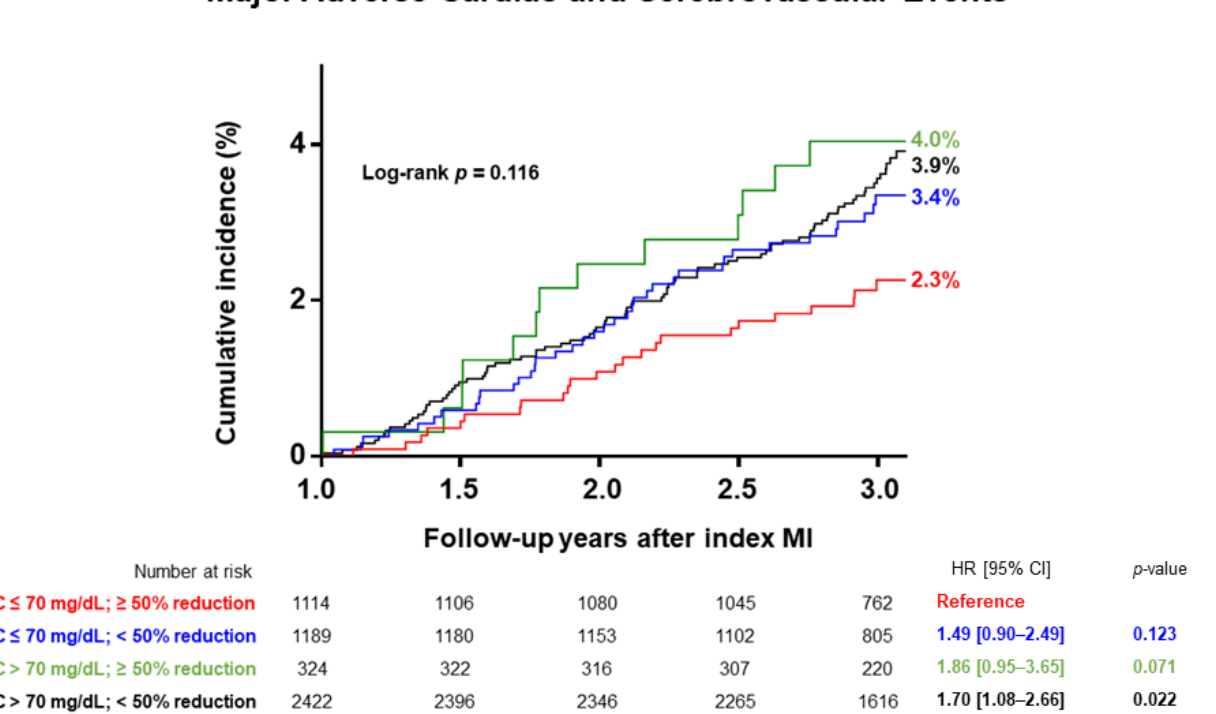
Figure 3. Cumulative incidence of the primary endpoint according to the achievement of either target LDL-C goal. CI, confidence interval; HR, hazard ratio; LDL-C, low-density lipoprotein cholesterol; MI, myocardial infarction. Table 3. Incidence and risk of primary and secondary endpoints.